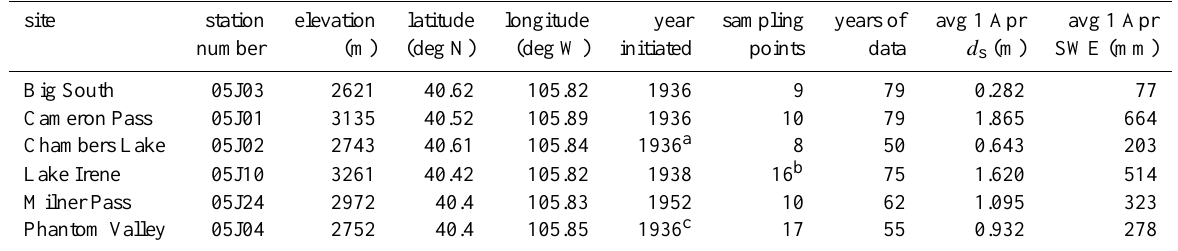
Table 1. Northern Colorado snowcourse data used in the analysis. The years of data are for 1 April measurements, with February, March and 1 May having almost as many samples. Some data are available for 1 January, 15 May and 1 June at all stations except Big South and Chambers